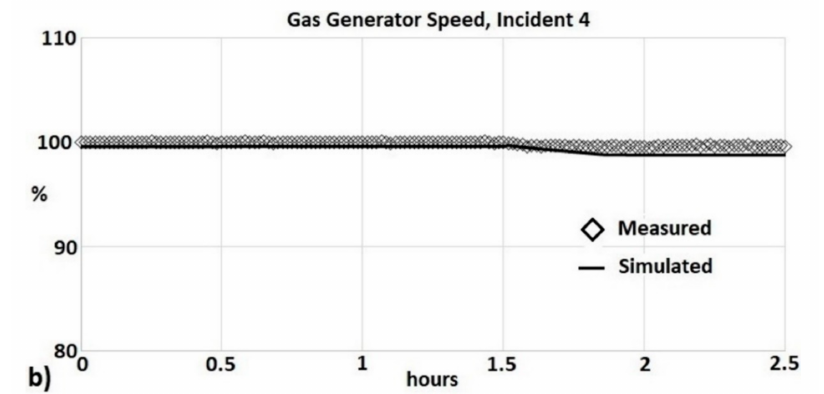
Figure 18. Measured and simulated gas generator speeds: ( a ) Incident 1; ( b ) Incident 4.